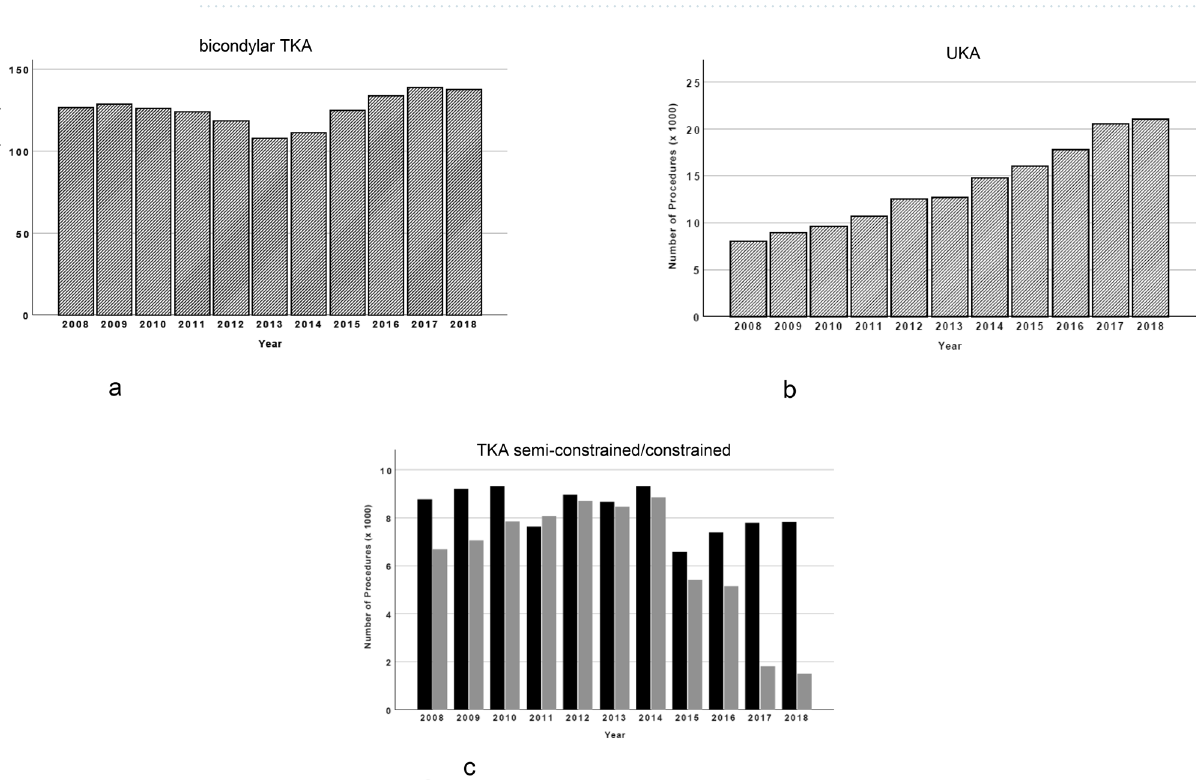
Figure 2. ( a ) All performed regular total knee arthroplasty procedures from 2008 to 2018. ( b ) All performed partial knee arthroplasty procedures from 2008 to 2018. ( c ) All performed semi-constrained and constrained total knee arthroplasty procedures from 2008 to 2018 (black = semi-constrained; grey =